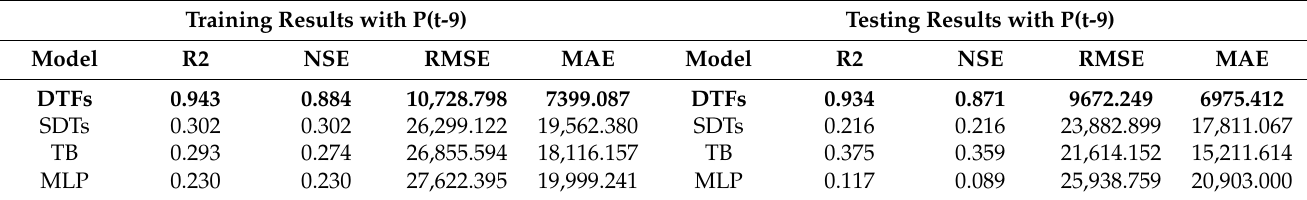
Table 9. Training and testing results with Q(t-8) of different data mining techniques.